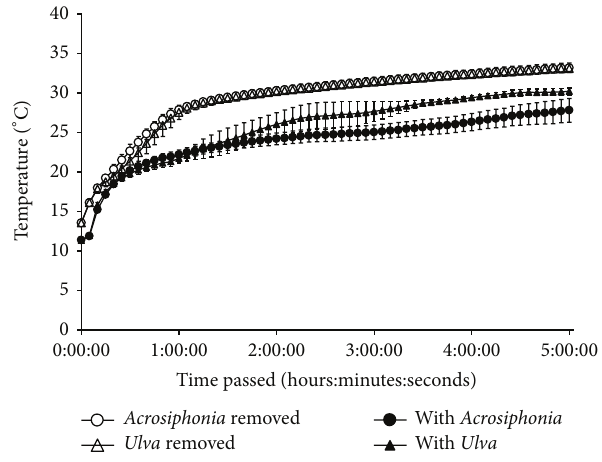
Figure 4: Internal limpet temperature as a function of time in the wind tunnel. Minimal differences were recorded until the one hour mark was approached. Data are ± standard deviation.